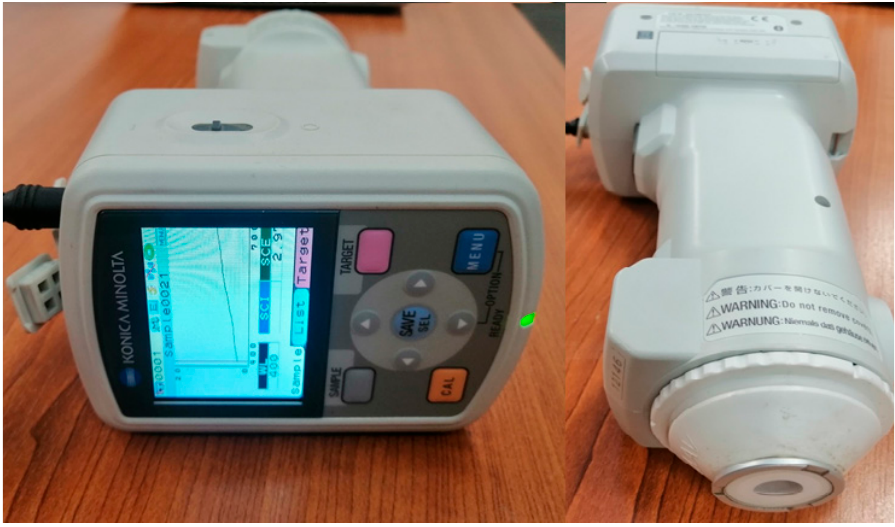
Figure 7. Spectrophotometer CM-700d.